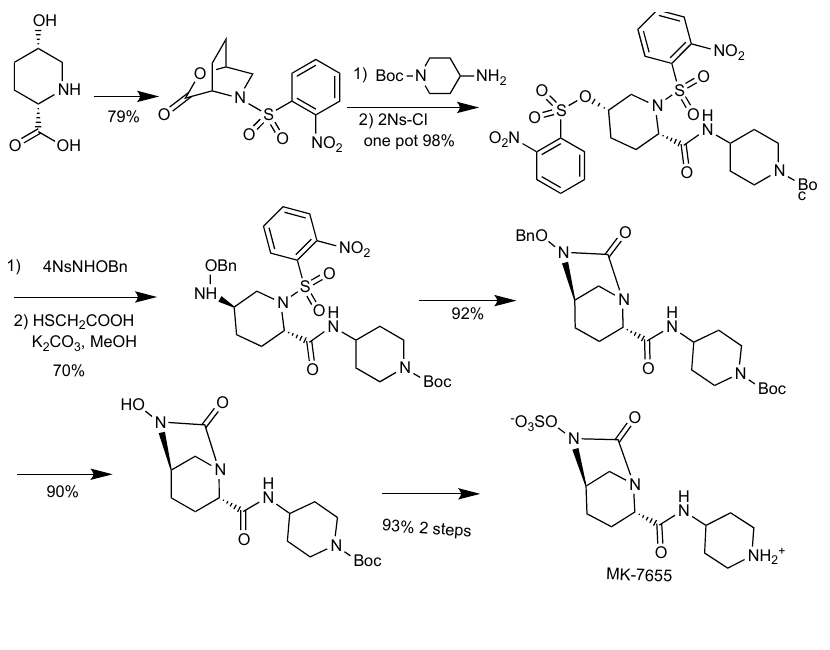
Figure 6. Reaction scheme for the improved synthesis of